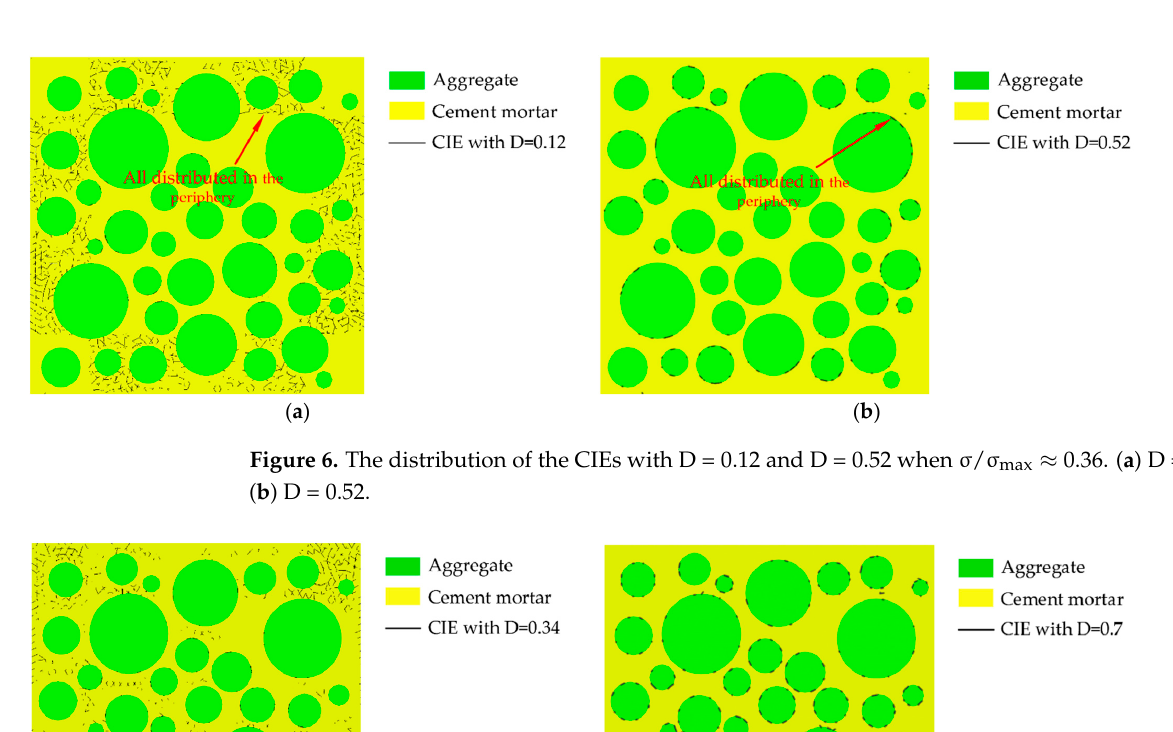
12 of 28 Figure 5. Comparison of stress-strain curves in uniaxial tension [2,44]. 3. Numerical Experimentation and Analysis Twenty-five CRAMs established according to the CVM were subjected to uniaxial tensile experiments to study the effects of total porosity, sub-porosity, average pore ra- dius, and PSSA on the failure process, tensile strength, tensile elastic modulus, and peak strain of concrete. 3.1. Failure Process Analysis The failure of concrete is a process in which micro-cracks continue to germinate, ex- pand, and penetrate to form macro-cracks [47]. Under different load levels, the cracking characteristics are significantly different. According to the previous research experience [48,49] and the visual cracking process obtained in this paper, the failure process of con- crete is divided into three stages: the relatively stable stage of micro-cracks, the stable de- velopment stage of cracks, and the unstable development stage of cracks. 3.1.1. The Failure Process of Concrete Specimen without Pores 1. The relatively stable stage of micro-cracks ( σ / σ max < 0.3~0.5); The damage degree of coh_mor and coh_CIE characterizes that of cement mortar and ITZ to some extent. At this stage, the internal stress of the concrete is small, and the visual cracking process shows that the damage of concrete first appears in the periphery of the specimen. Later in this stage, most of the damage variables of coh_mor are less than 0.45, and all of them are distributed in the periphery of the specimen. Figure 6a shows the dis- tribution of CIEs with damage variable D = 0.12 when σ / σ max ≈ 0.36, where the black line segments represent CIEs, the green circle represents aggregate, and the yellow area rep- resents the mortar. The damage variables of coh_ITZ are mainly distributed in the range